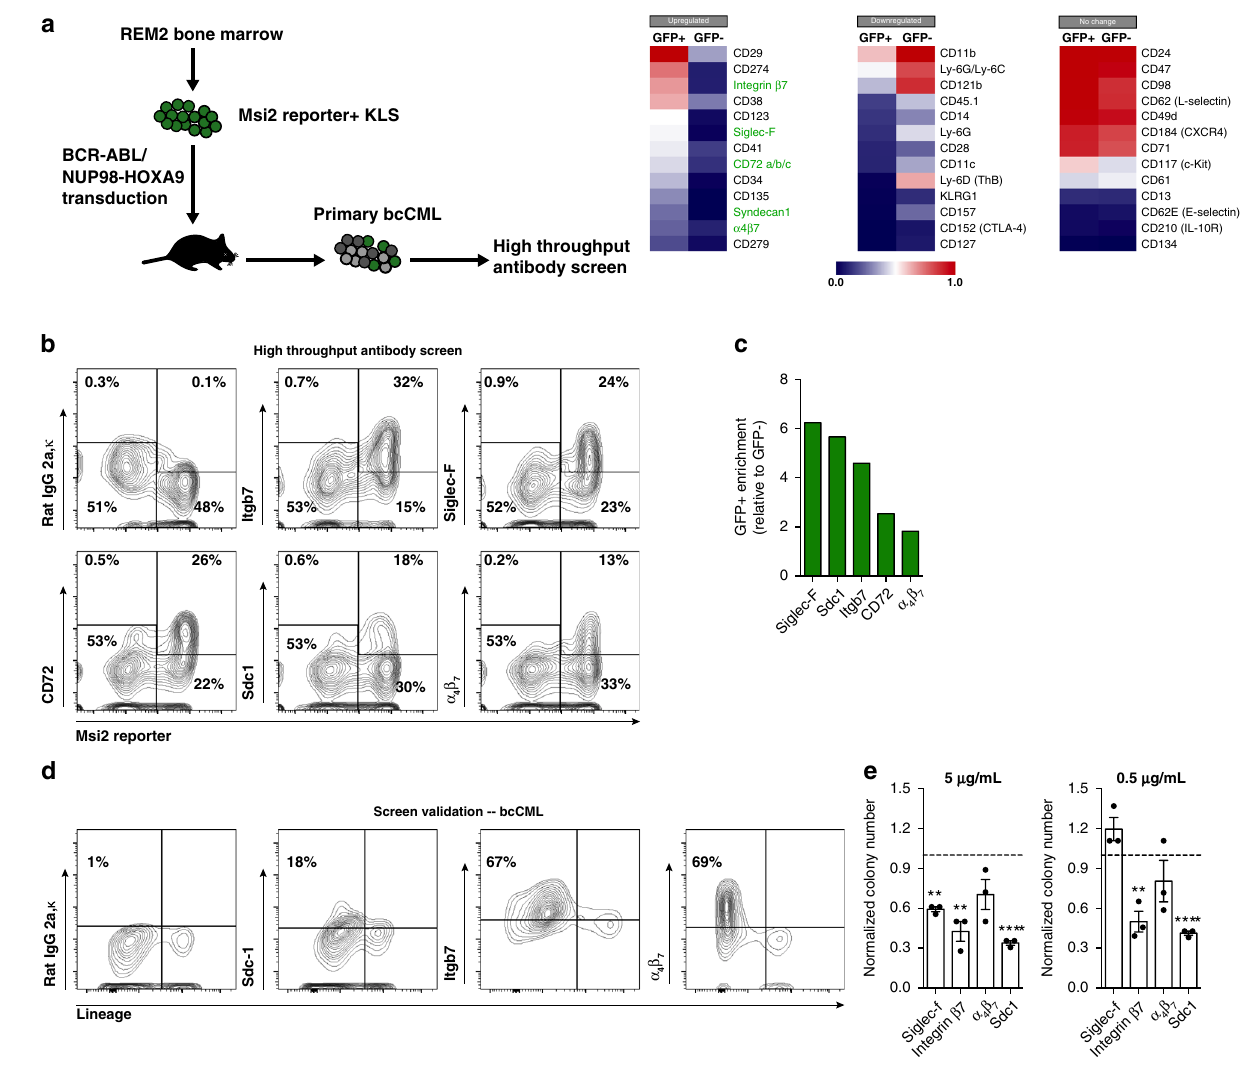
Fig. 3 High throughput screen identi fi es cell surface proteins with functions in Msi2-reporter bcCML cells. a Schematic illustrates the experimental approach used for FACS-based high throughput antibody screen to identify surface proteins that are differentially expressed in Msi2 + and Msi2 − bcCML cells. bcCML was generated from KLS cells derived from Msi2 reporter (REM2) mice. Heat maps display selected genes that are more highly expressed in GFP + bcCML cells (left panel) or GFP − bcCML cells (center panel), or that are unchanged between GFP + and GFP − bcCML cells (right panel) ( n = 1 technical replicates, representative of two biological replicates for each group). b FACS plots generated from high throughput antibody screen show increased expression of the indicated proteins on GFP + bcCML relative to GFP − bcCML. c Enrichment of protein expression on GFP + bcCML relative to GFP − bcCML based on high throughput screen ( n = 1 technical replicates, representative of two biological replicates for each group). d Representative FACS plots validating expression of the indicated proteins using individual fl uorescently conjugated antibodies in freshly isolated bcCML cells. e The relative number of colonies (normalized to IgG control) generated from bcCML cells in the presence of blocking antibodies against the indicated proteins at either 5 μ g/mL (left) or 0.5 μ g/mL (right). Signi fi cance from IgG control: 5 μ g/mL, Siglec-f ** P = 0.003, Integrin β 7 ** P = 0.004, Sdc1 **** P < 0.0001; 0.5